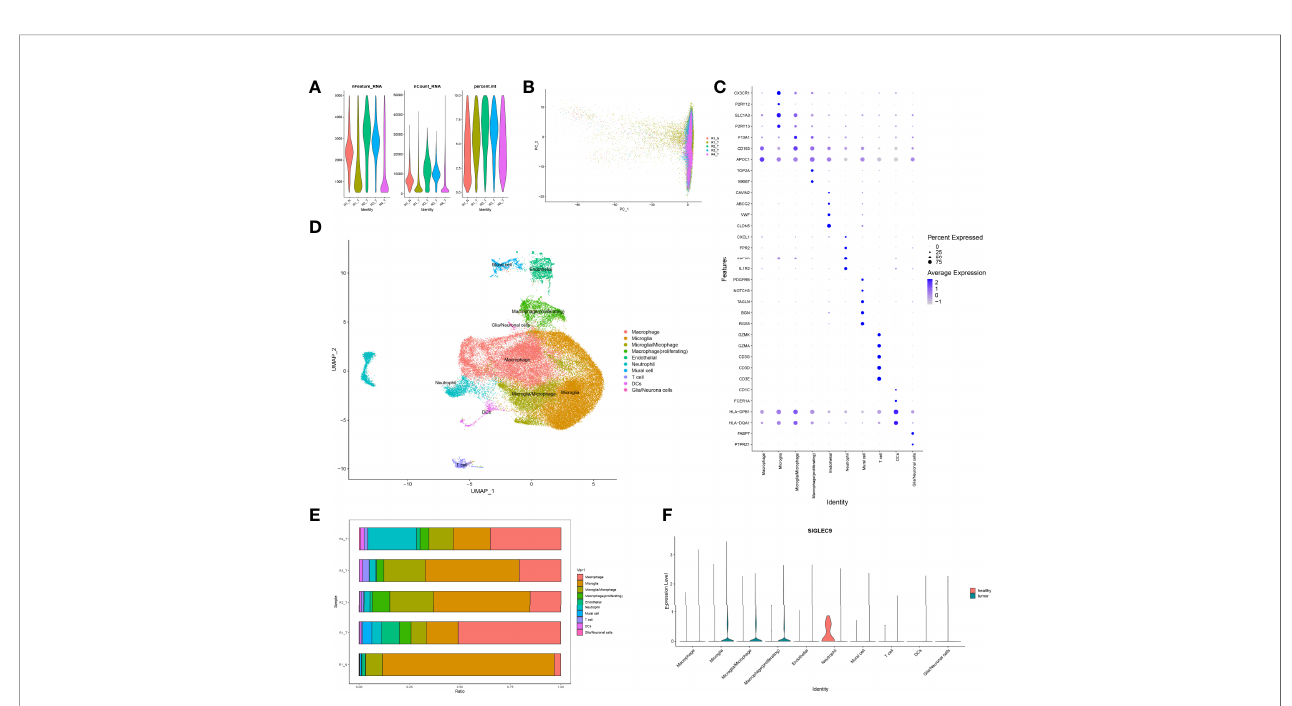
FIGURE 6 | Identi fi cation of differentially expressed genes and cell subsets in glioma with single-cell analysis. (A) High-quality cell fi ltration. The cells were fi ltrated with the number of genes in cells nFeature >200 and ≤ 5,000; the proportion of mitochondrial genes in cells (percent.mt <10). (B) Integration of all samples. (C) Bubble plot of marker gene expression in the identi fi cation of different cell types. (D) Exhibition of cell subsets. (E) Proportion of cells in each sample. (F) Expression of SIGLEC9 in tumor tissue and in adjacent